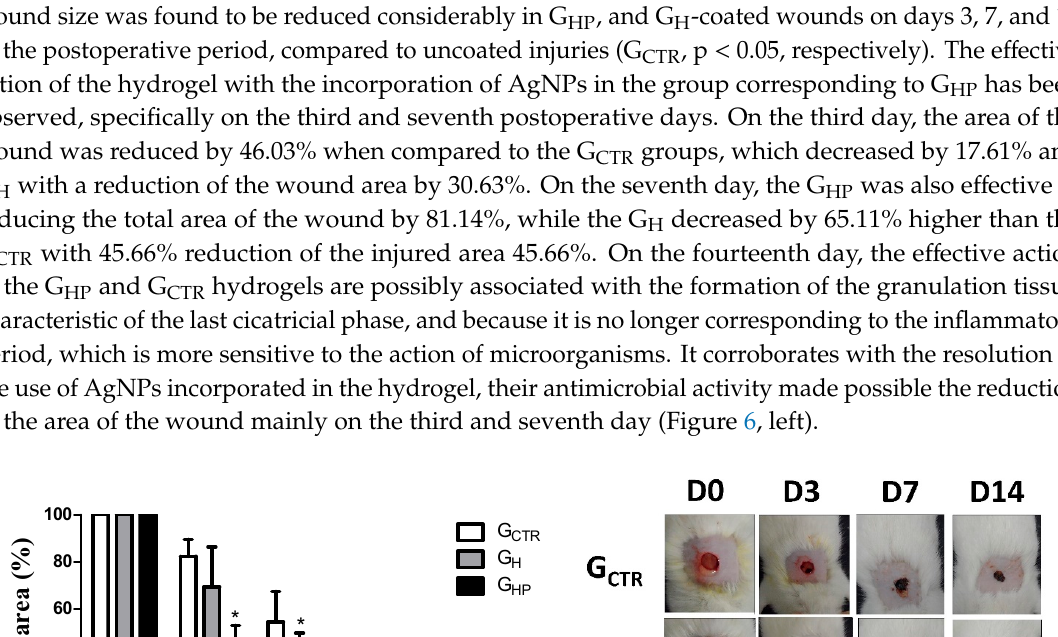
OLD IMAGE (WRONG ONE) The authors apologize for any inconvenience caused and confirm that the scientific conclusions are unaffected. This correction was approved by the Academic Editor. The original publication has also been updated.